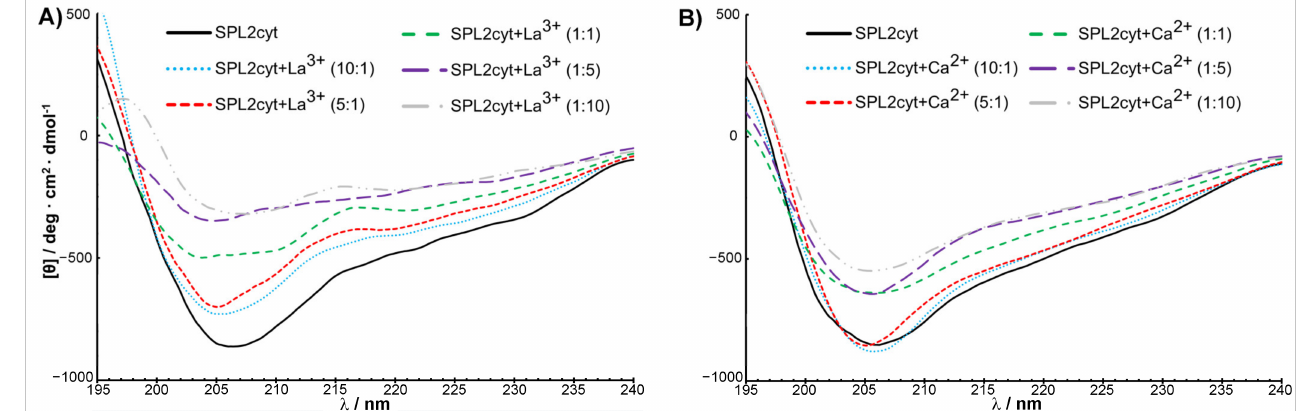
Figure 6. SPL2cyt undergoes a conformational change in the presence of La 3+ or Ca 2+ ions. Far-UV CD spectra of SPL2cyt (8 µ M) in the presence of ( A ) La 3+ or ( B ) Ca 2+ at indicated molar ratios.